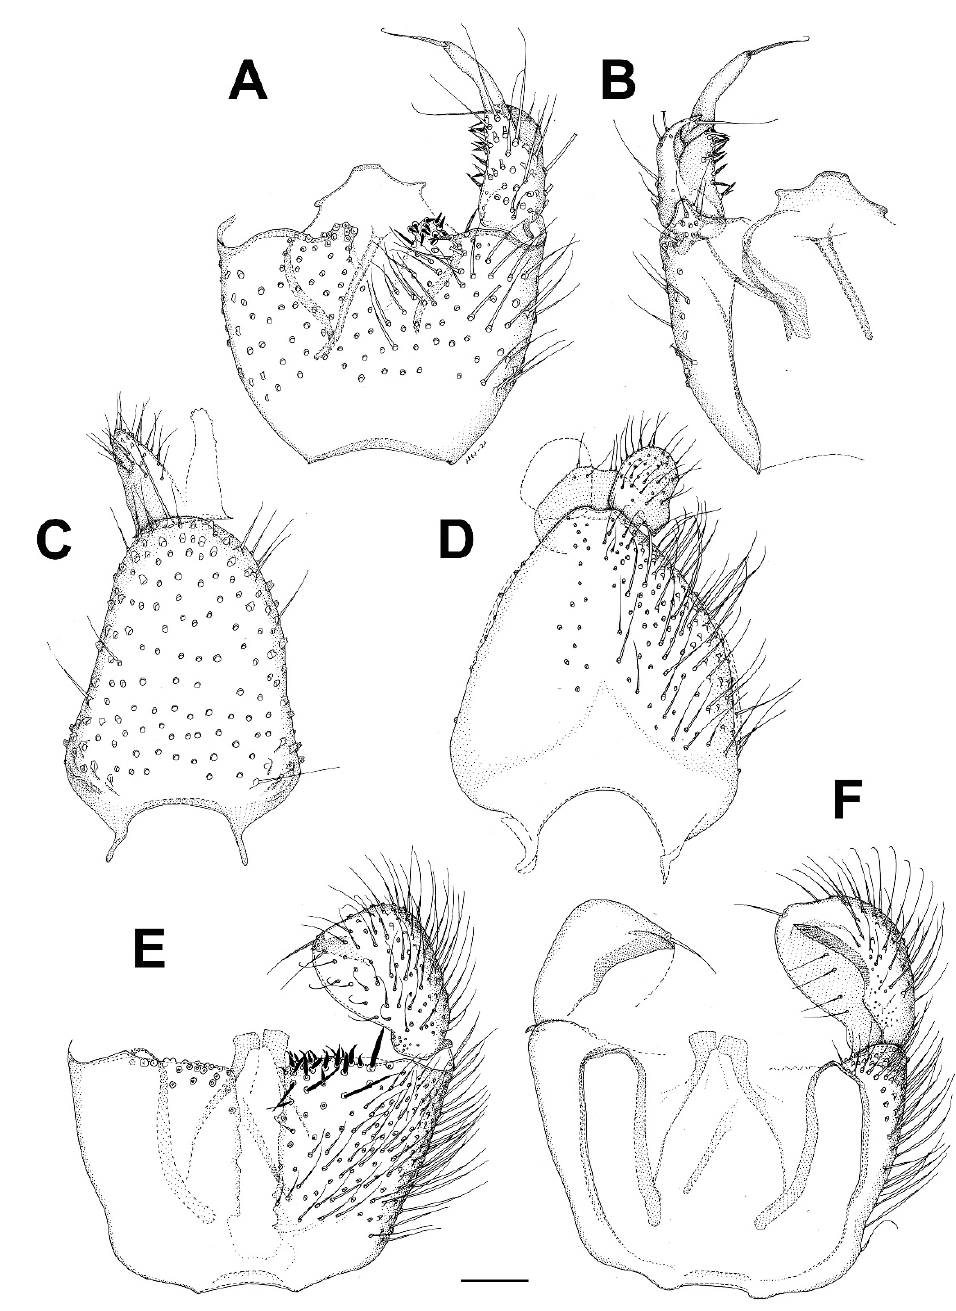
Figure 14. Male terminalia of new species of Keroplatidae. Setostylus fangshuoi sp. nov. (holotype): ( A ) ventral view, ( B ),dorsal view, ( C ) tergite 9 with cerci; Terocelion adami sp. nov. (holotype); ( D ) tergite 9 with cerci, ( E ) ventral view, ( F ). dorsal view. Scale bars: 0.1 mm. Description. Male. Wing length 3.8 mm. Body mostly dark brown, except for the yellow antennal flagellum and partly yellow legs (Figure 15B). Two ocelli, near the eye margin, but not touching it. Distinct frontal suture, reaching from the antennae to the occiput. Antenna with 14 yellow cylindrical flagellomeres. Scape and pedicel yellowish brown. Mouthparts normal, not distinctly reduced or prolonged. Palpus brown, with four visible palpomeres, the apical one twice as long as the previous one. Scutum with acrostichal, dorsocentral and lateral setae; areas between them bare. Scutellum dark, covered with short setulae and several longer bristles. Laterotergite with long